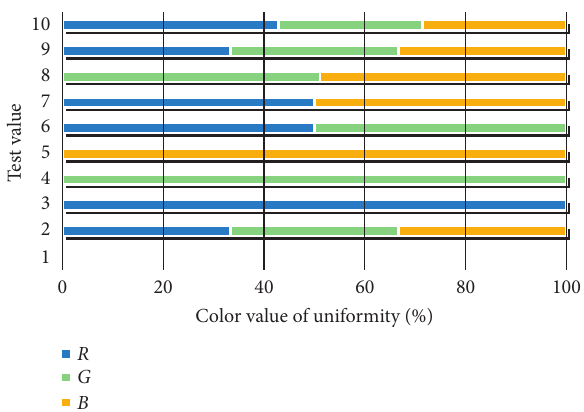
Figure 9: The test animation shows the color value of uniformity.